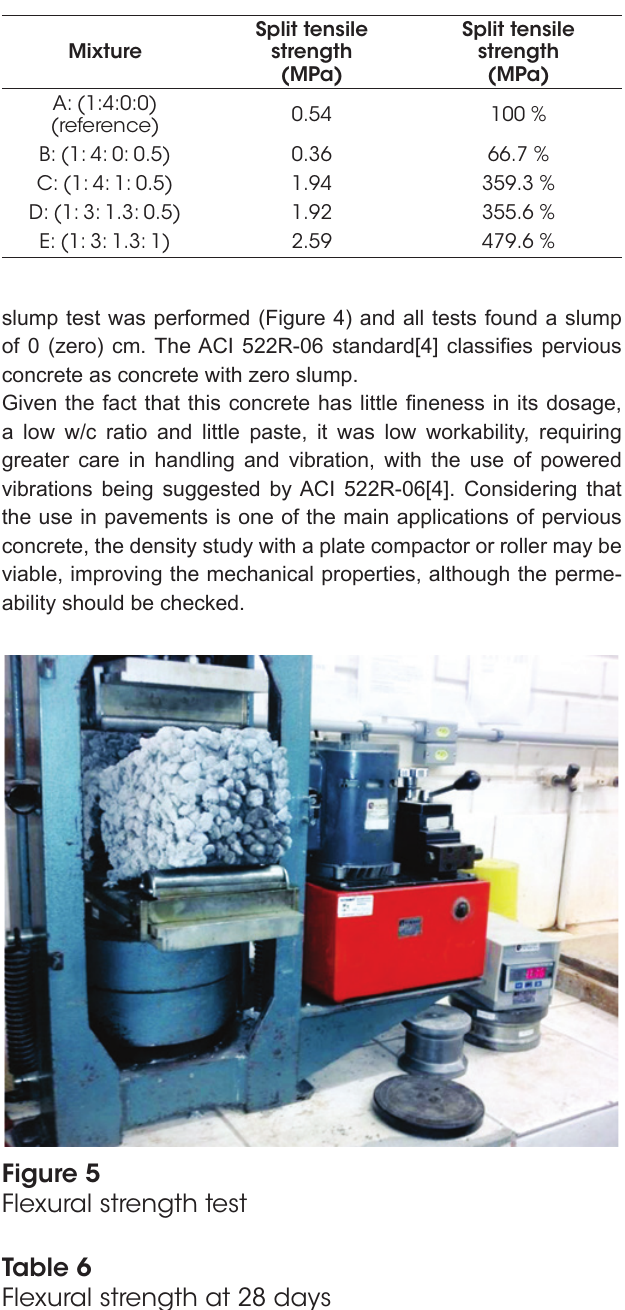
Split tensile strength at 28 days